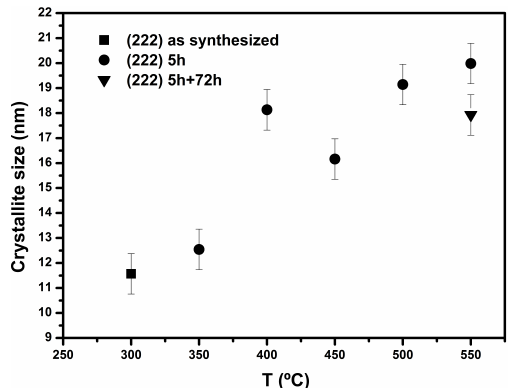
Figure 6. Crystallite sizes derived from the (222) peaks using the Scherrer equation for samples before and after heat treatment. Error bars: standard deviation of the mean value of the crystallite size of 12 different “as-synthesized” samples.